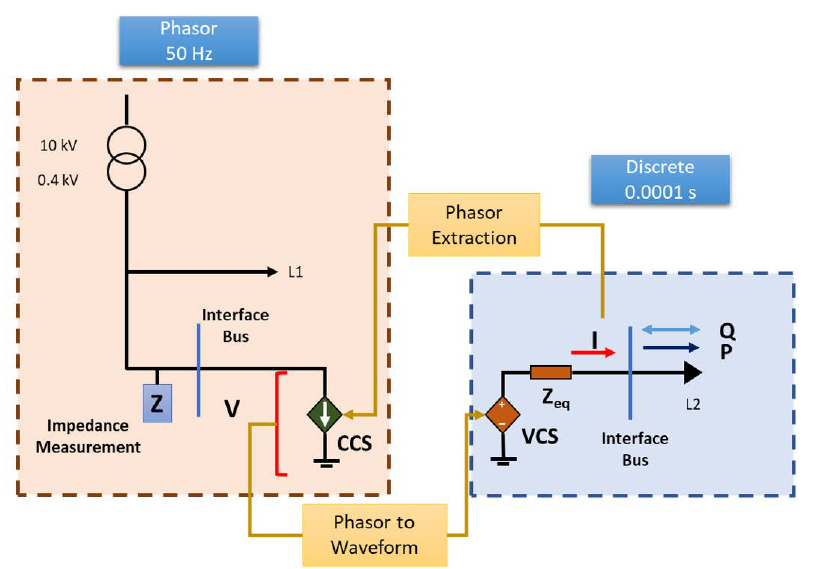
Figure 4. Development and workflow of hybrid simulation model for a power distribution grid with one interface